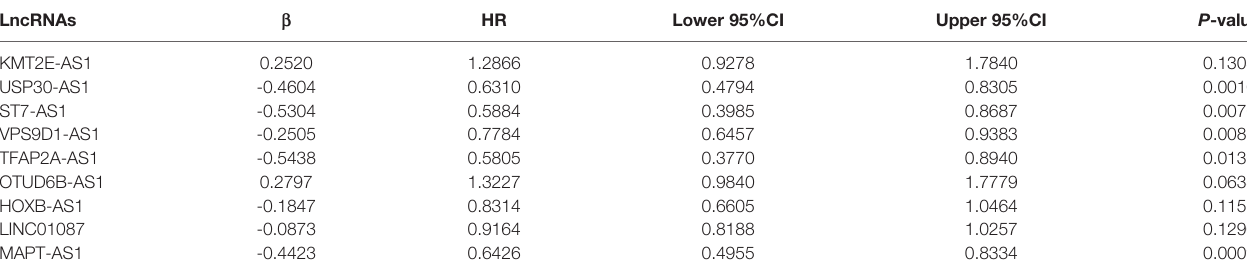
TABLE 3 | The 9 autophagy-related lncRNAs signi fi cantly associated with OS in the training set.